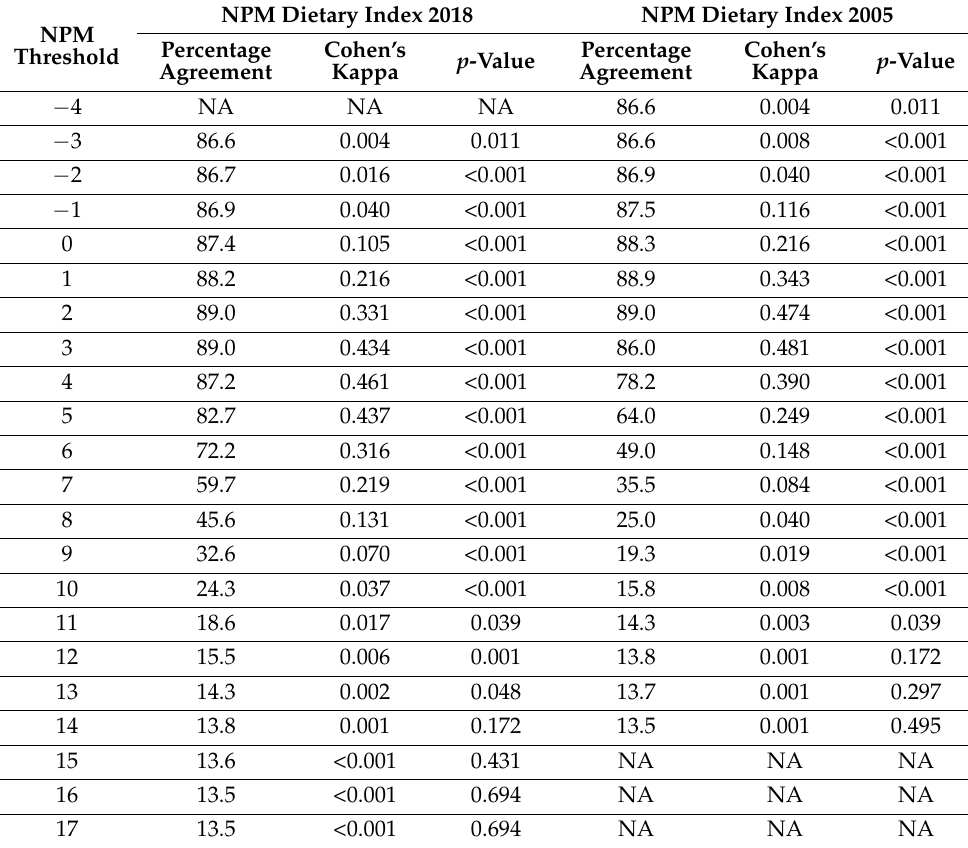
Table 3. Agreement regarding the healthiness of diets between the EWG score and the NPM dietary index 2018 and 2005 across different thresholds of the NPM dietary